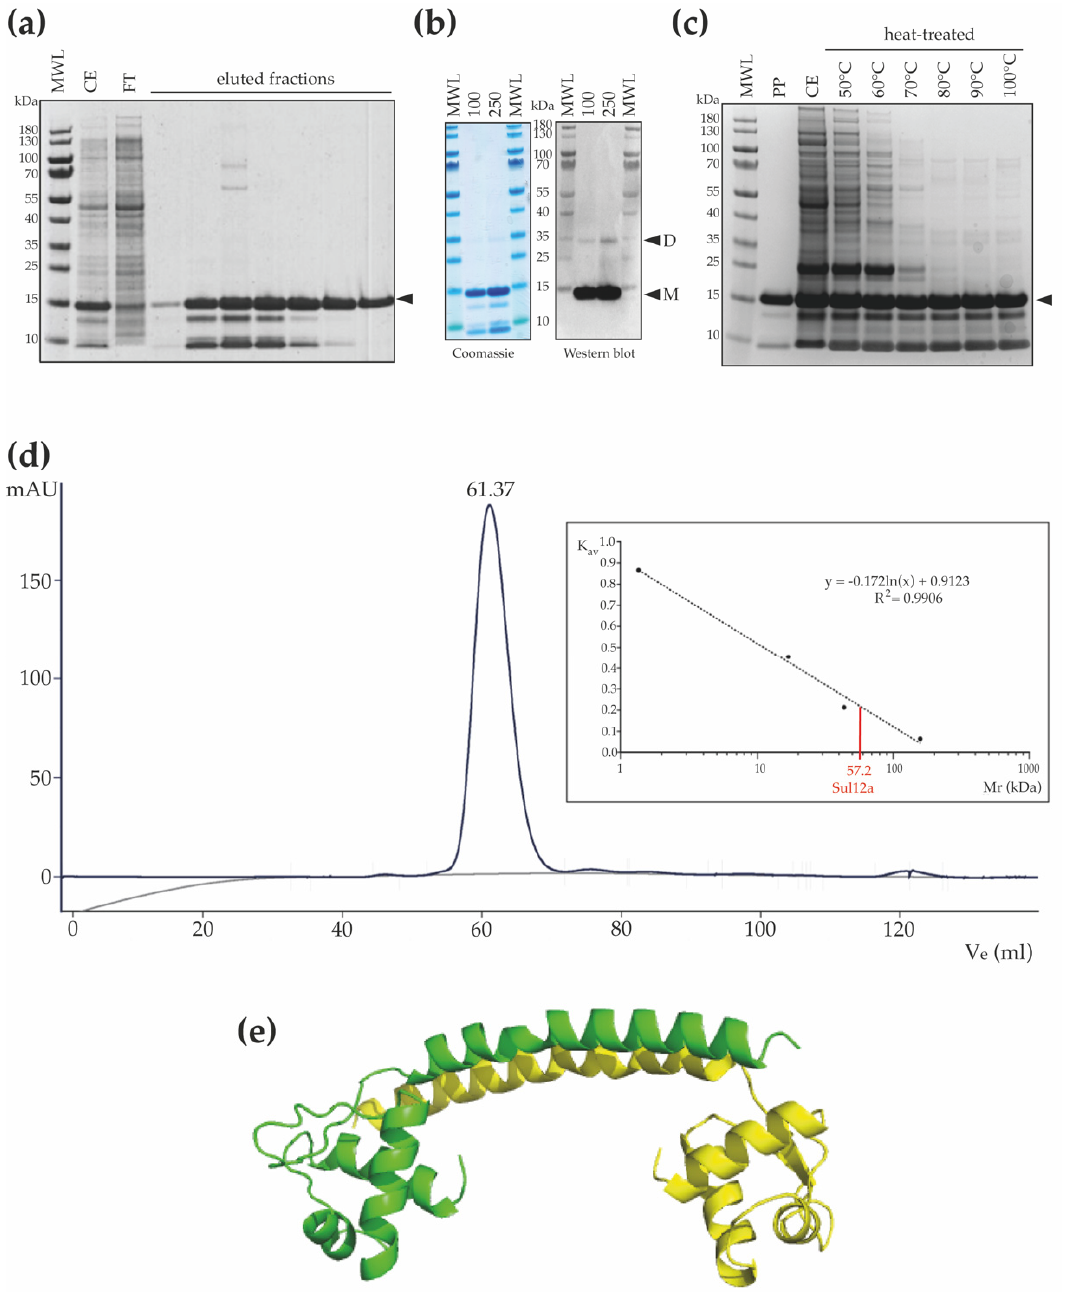
Figure 3. Thermostability and oligomeric characteristics of Sul12a. ( a ) SDS-PAGE of eluted fractions after His-tag affinity chromatography. MWL = molecular weight ladder; CE = crude extract; FT = flowthrough. The monomeric recombinant protein is indicated with a black arrowhead (MW 14.3 kDa). ( b ) SDS-PAGE and western blot of purified Sul12a protein. On the western blot, the molecular weight ladder (MWL) is visible via an aligned overlay. Protein amounts are indicated in µg. “M” stands for a band corresponding to a monomeric state, and “D” stands for a band corresponding to a dimeric state. ( c ) SDS-PAGE of Sul12a-containing crude extracts subjected to a heat treatment at different temperatures. PP = purified protein; CE = crude extract. ( d ) Chromatogram of size exclusion chromatography of recombinantly purified Sul12a protein. The inset displays the calibration curve with indication of the calculated molecular weight of Sul12a based on the measured elution volume (displayed above the elution peak). ( e ) Cartoon representation of a dimeric structural homology model of Sul12a, predicted by the SWISS-Model based on the N-terminal structure of TrmBL2 (PDB 5BPI) as a template. Each monomeric subunit is depicted in a different color.